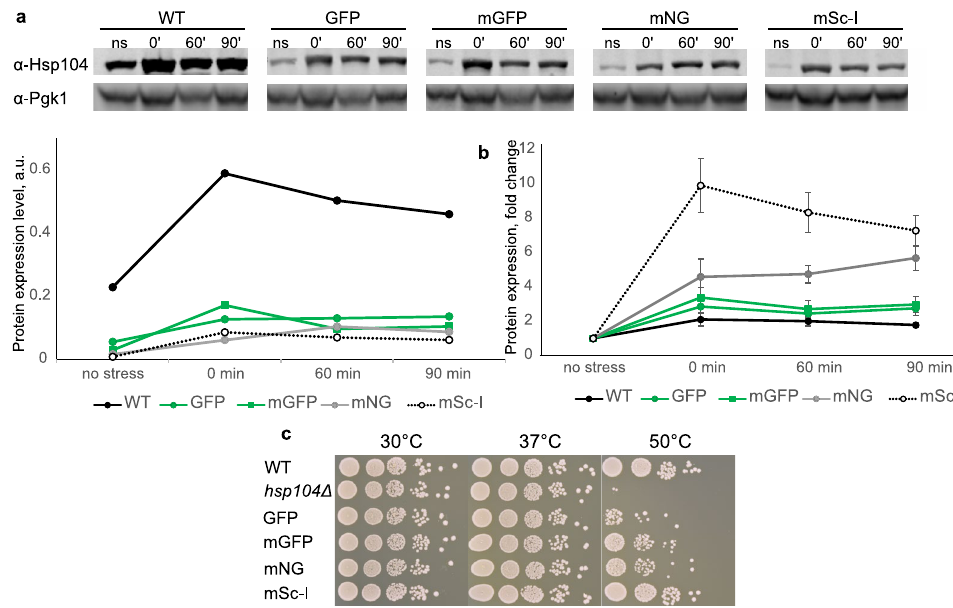
recovery at 30 °C, 180 rpm, in the wild type (WT) strain and cells expressing Hsp104 tagged with GFP, mGFP, mNeonGreen (mNG) and mScarlet-I (mSc-I). Bottom: Normalised Hsp104 expression relative to Pgk1. ( b ) Hsp104 protein expression change right after the heat stress, and 60 and 90 min recovery relative to the initial expression level in the wild type (black circles) and cells with Hsp104 labelled with GFP (green circles), mGFP (green squares), mNG (grey circles) and mSc-I (empty circles). SEM error bars. ( c ) 3 days recovery at 30 °C of the wild type (WT), hps104Δ and strains expressing Hsp104 fused with GFP, mGFP, mNG and mSc-I after the thermal insult at 50 °C for 30 min with a pretreatment at 37 °C for 30